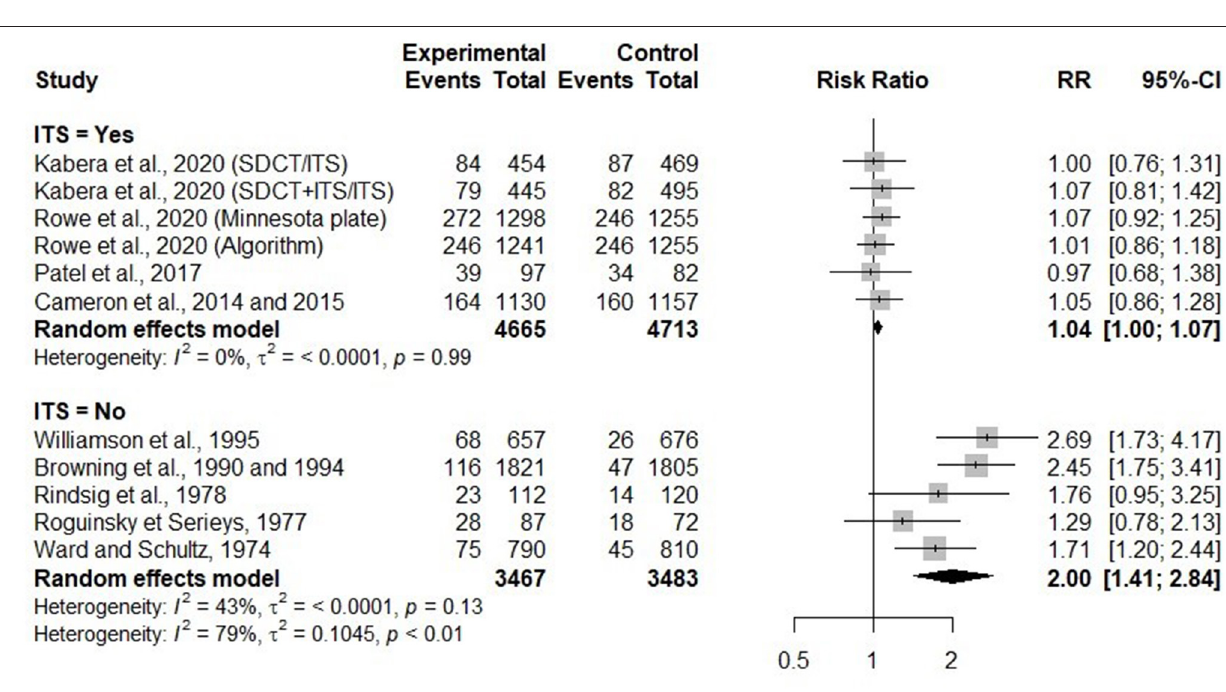
FIGURE 4 | Forest plots showing the effect of selective dry cow treatment compared with blanket dry cow therapy on risk of acquiring new IMI during the dry period, grouped by studies where untreated cows/quarters with antimicrobial received an internal teat sealant (ITS = Yes) and those where they did not receive an internal teat sealant (ITS =